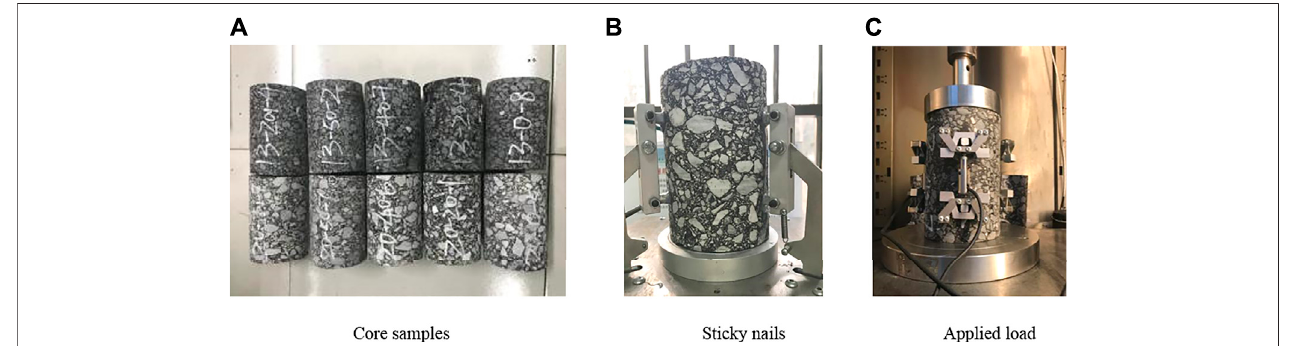
FIGURE 1 | Dynamic modulus test